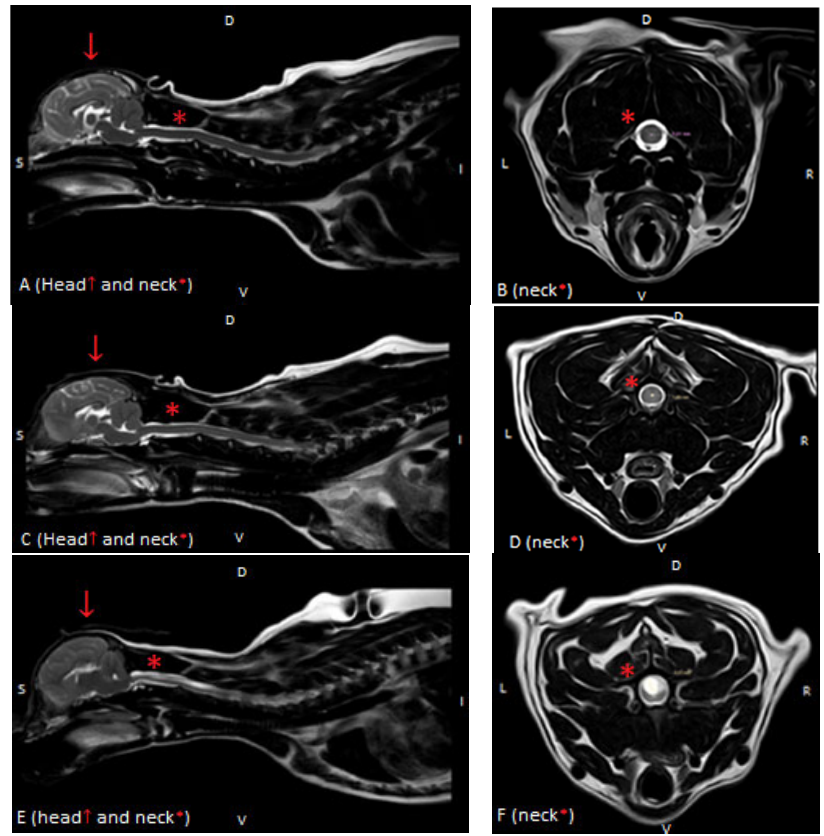
Figure 1. T2 ‐ weighted MR images of the spinal cord in the sagittal ( A , C , E ) and transverse ( B , D , F ) planes in three dogs showing: ( A , B )—normal spinal cord (Grade 0), ( C , D )—central canal dilatation (Grade 1) and ( E , F )—syringomyelia (Grade 2). There is severe flattening of the caudal fossa with marked compression of the cerebellum and crowding of the cerebellum ( A , C , E ).